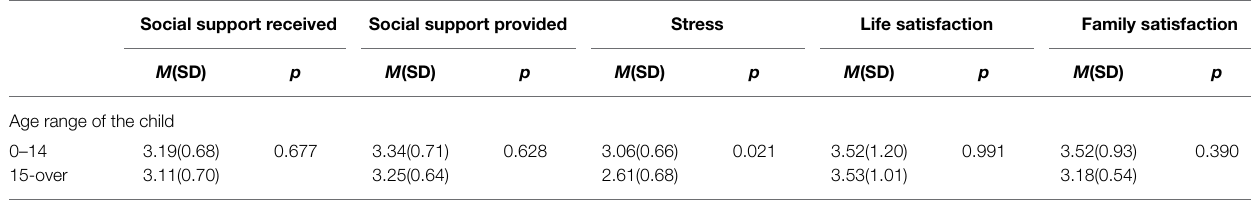
TABLE 4 | Mean differences in social support, stress, life satisfaction and family satisfaction according to the age range of the